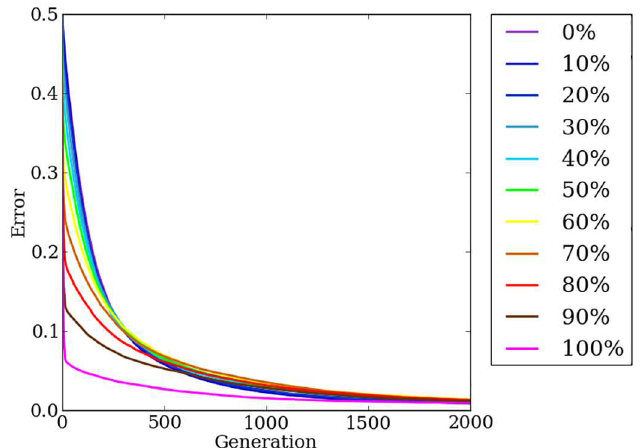
Fig 8. The mean error of Offset-HybrID generation champions over 2,000 generations on the target weights experiment. The line colors indicate the regularityof the problem tested.